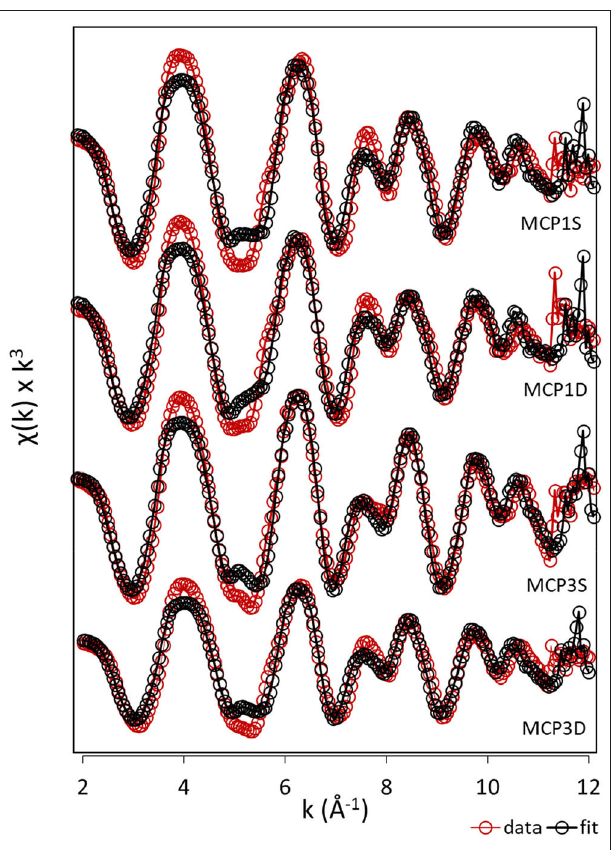
FIGURE 2 | EXAFS analysis. k 3 -weighted EXAFS spectra and fits of sediment samples collected from MCP1 and MCP3 wells at shallow (S) and deep (D) zones (top to bottom). Red and black dotted lines indicate the experimental and fitted Fe K-edge EXAFS spectra, respectively.